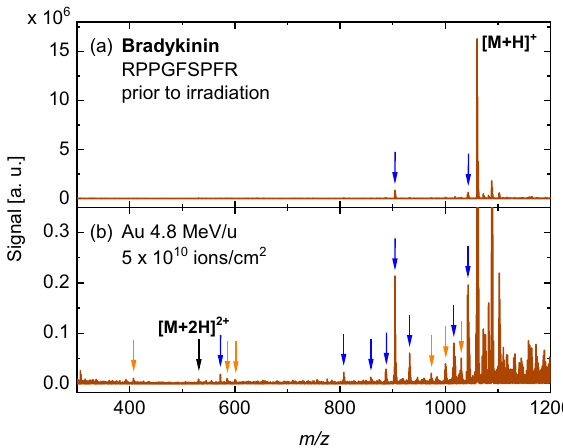
Figure 5. DINeC mass spectra from ( a ) a freshly prepared bradykinin sample and ( b ) the same sample irradiated with Au ions (946 MeV). Fragments observed prior to irradiation at m / z = 904.3 and 1043.5 are due to the loss of one of the molecules’ terminal arginine groups or an OH group, respectively, when the film is exposed to ambient atmosphere. SHI irradiation leads to additional fragmentation (Tab. S3); overall, fragment peaks are less abundant when compared to DINeC mass spectra of angiotensin II or neurotensin. The signal intensity close to the peak of the intact molecule ( m / z > 1060 ) is comparable to the measurement before irradiation but appears more pronounced in ( b ) due to the smaller signal scale.